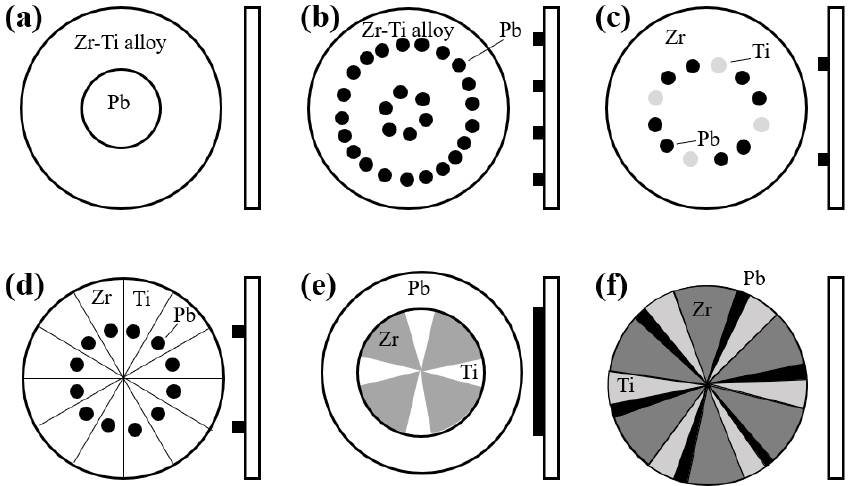
Figure 3. Different target designs for DC reactive sputtering. Reprinted with permission from [22] Copyright 2005 Elsevier. ( a ) Zr–Ti alloy with Pb in the center; ( b ) Zr–Ti alloy with Pb cylinders on the surface; ( c ) Zr target with Pb cylinders and Ti cylinders on the surface; ( d ) Zr–Ti alloy with flabellate distribution and Pb cylinders on the surface; ( e ) Pb target with fan-shaped Zr–Ti alloy in the center; ( f ) Zr–Ti–Pb ternary alloy target with flabellate distribution.